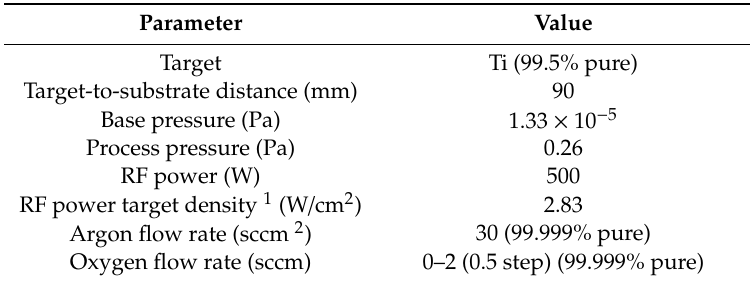
Table 1. Deposition parameters for the TiO 2